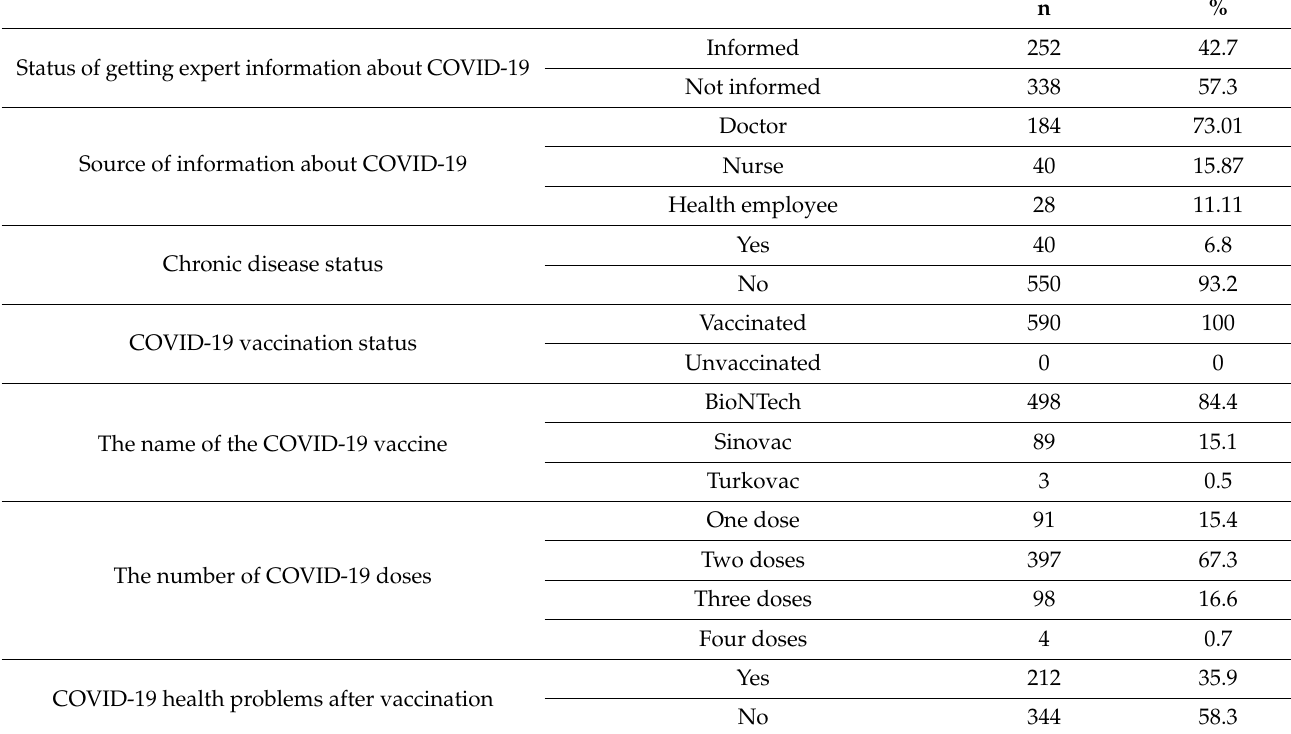
Table 2. Distribution of students’ characteristics regarding the COVID-19